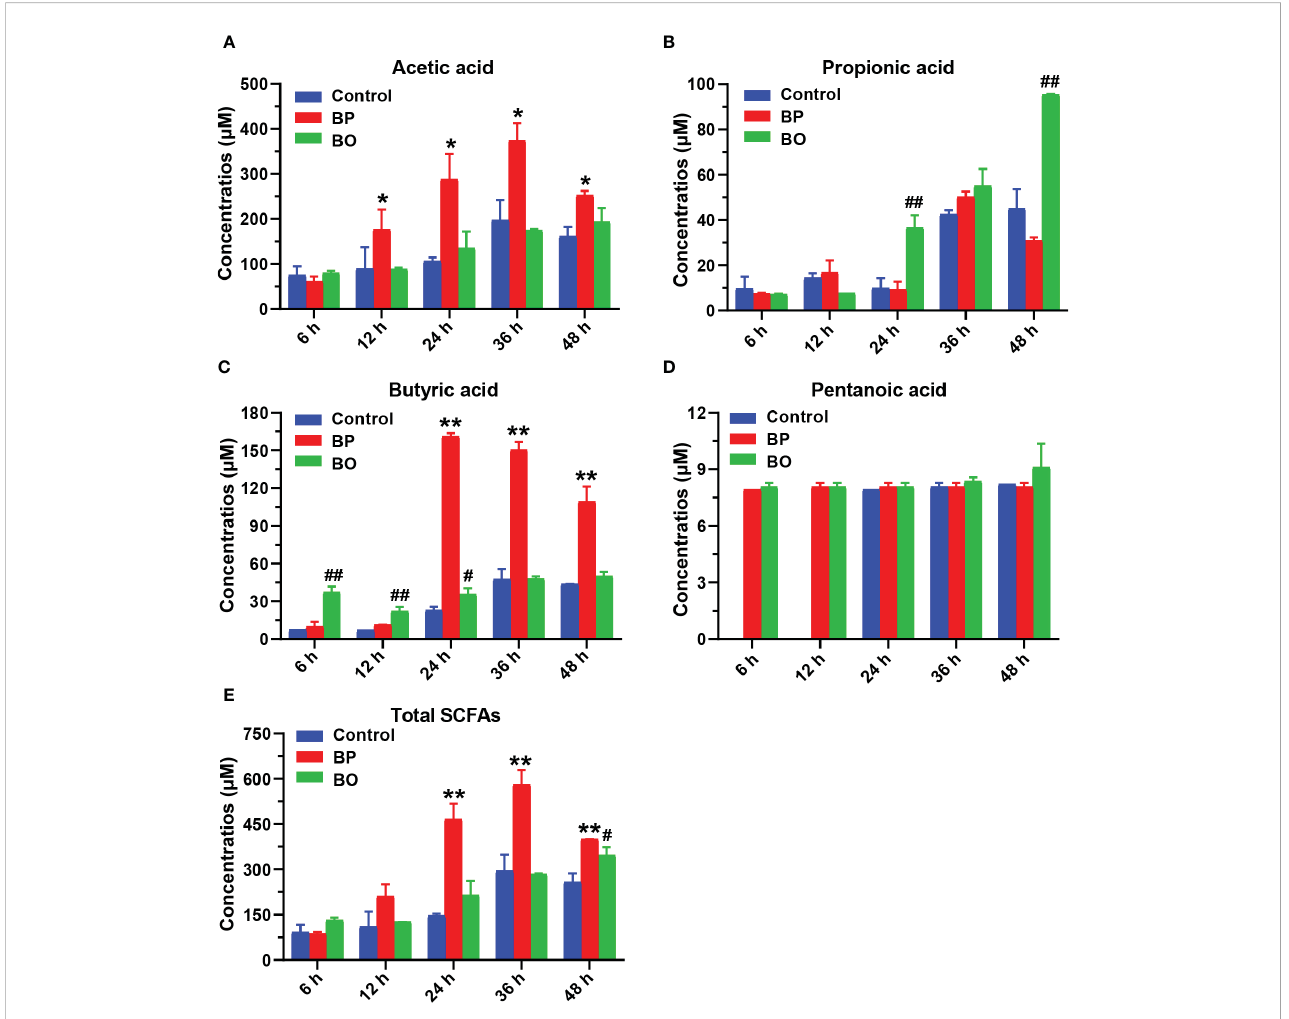
FIGURE 7 Concentrations of short-chain fatty acids (SCFAs) in culture medium after gut microbiota fermentation for 0, 6, 12, 24, 36, and 48 h. (A – E) Concentrations of Acetic acid (A) , Propionic acid (B) , Butyric acid (C) , Pentanoic acid (D) , and Total SCFAS (E) in the culture medium during the fermentation period. Data were presented as mean ± SD (n = 3). * p < 0.05, ** p < 0.01, Control group vs. BP group; # p < 0.05, ## p < 0.01, Control group vs. BO